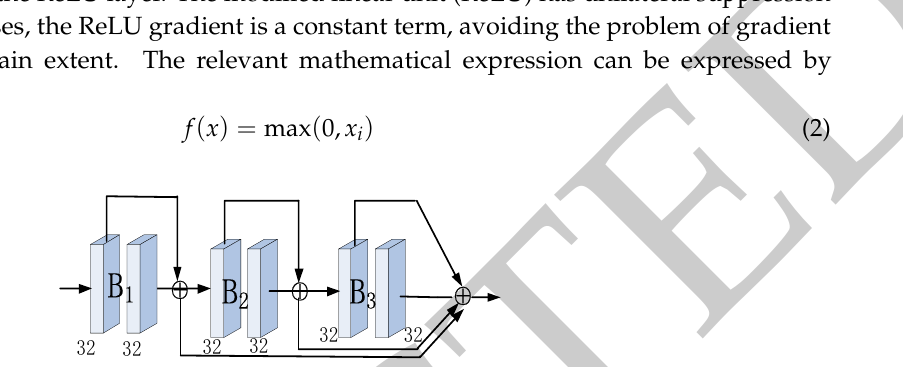
Figure 4. The processing construction of long-term and short-term memory blocks.